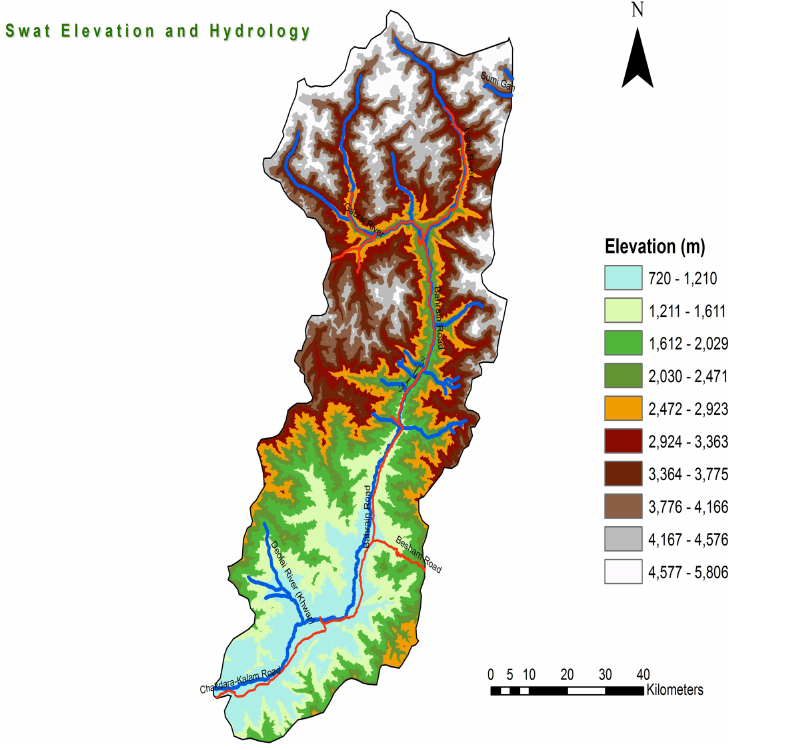
Fig 1. Map of Swat, Khyber